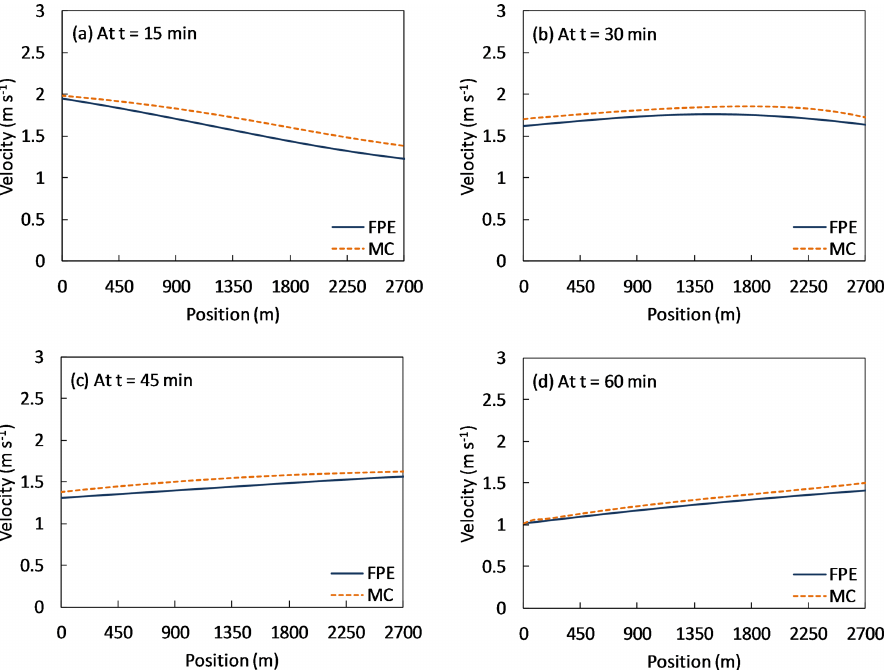
Figure 6. Comparison of the ensemble average velocity obtained by the FPE methodology and the MC approach as a function of channel location, at different times.